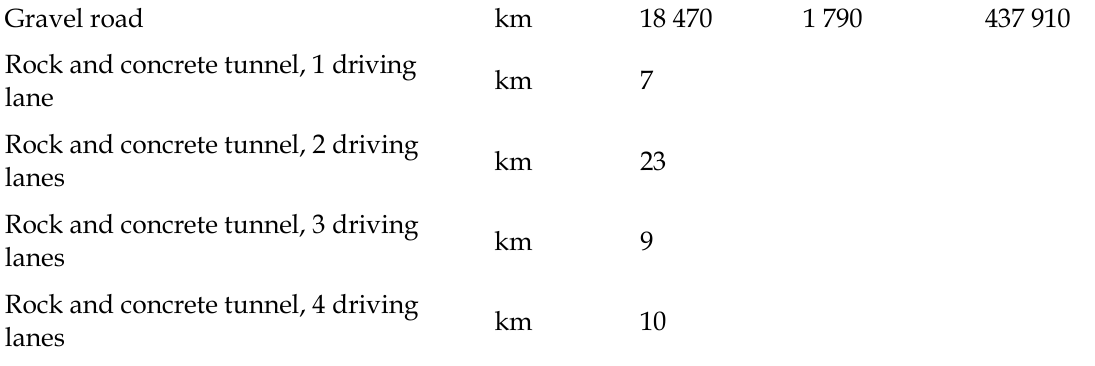
Table A6. Reinvestment of road infrastructure: the road infrastructure stock divided into standard measures representative of the standard measures in Klimatkalkyl 4.0. The length of plain roads was assumed to include also roads in roundabouts and junctions. The surface area of bridges was assumed to include also bridges in junctions. Stone and wood bridges, vault bridges, and soil composite bridges (representing 10% of the bridge area on the state-owned road network and most bridges on the private road network) were not